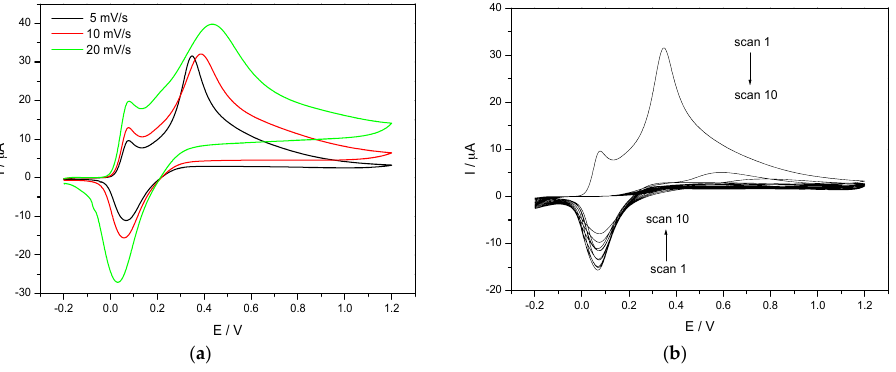
Figure 1. ( a ) First CVs of SPCE in 2 mM 2,6-DHN prepared in 0.1 M PBS pH 7.4 recorded at the scan rates 5, 10 and 20 mV · s − 1 ; ( b ) 10 successive CVs of SPCE in 2 mM 2,6-DHN at scan rate 5 mV · s − 1 .